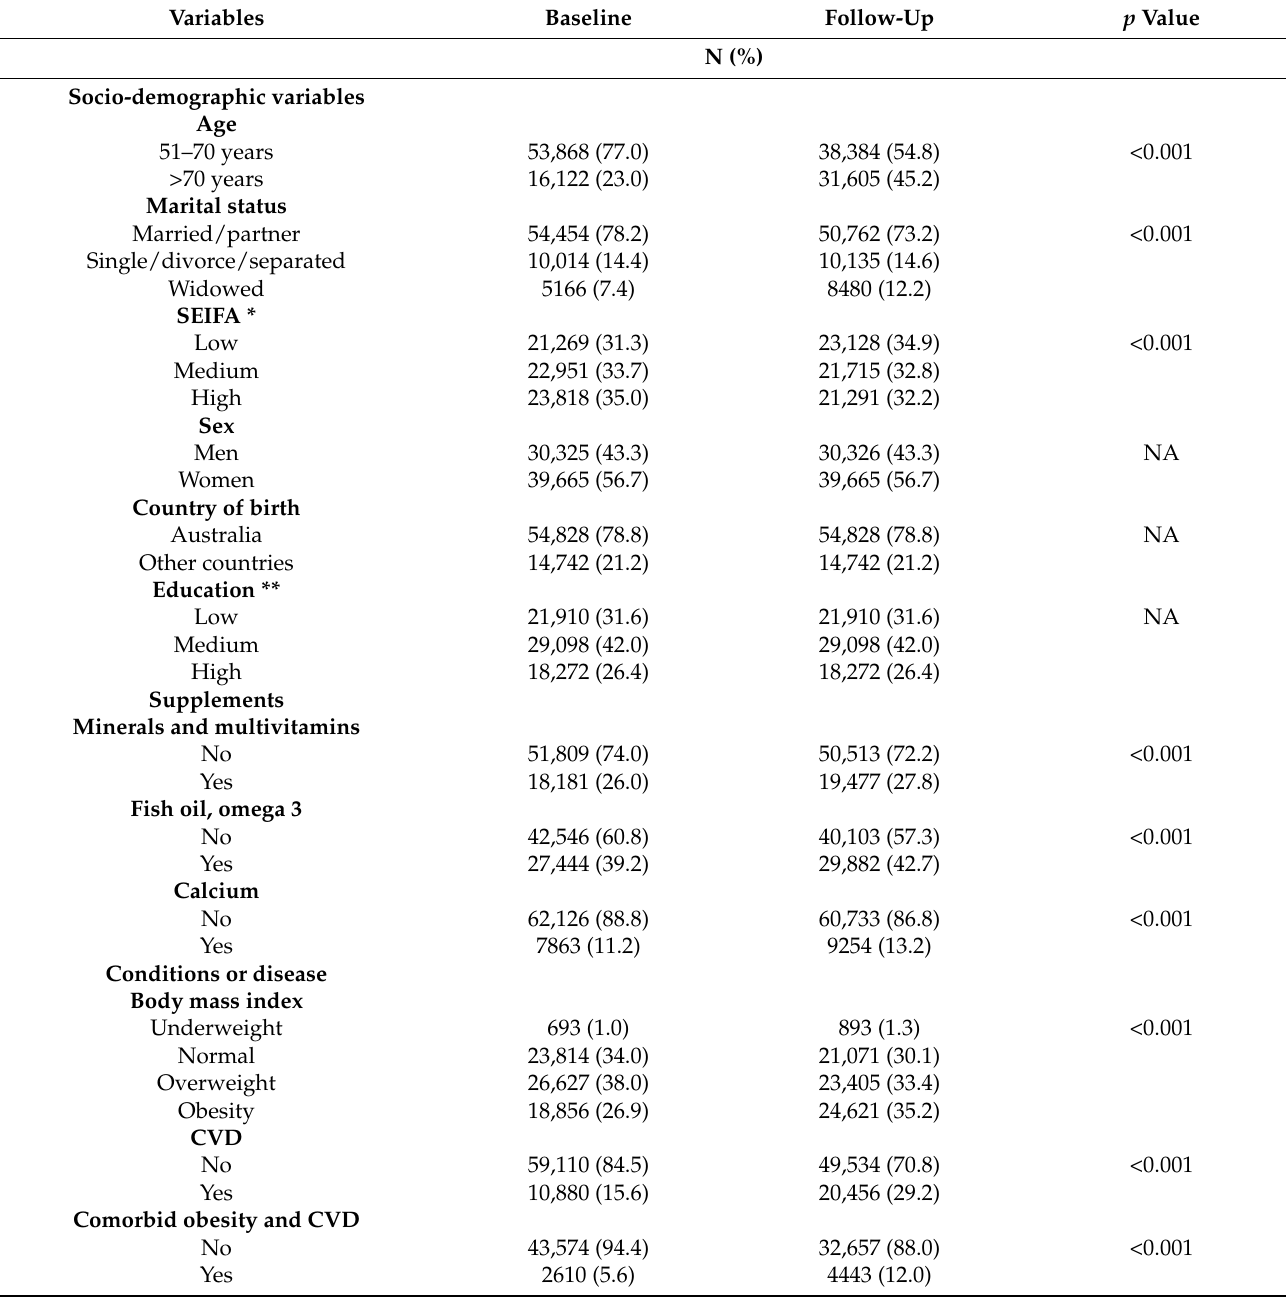
Table 1. Participant characteristics at baseline and